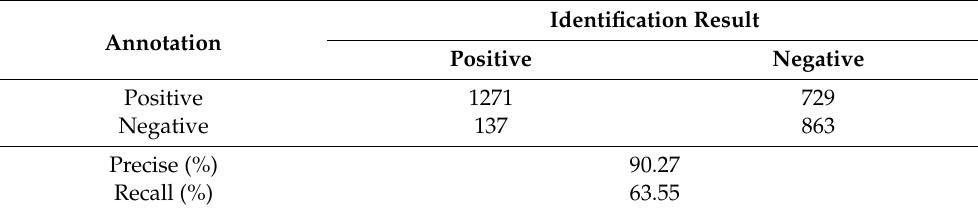
Table 1. The identification result of fold structures on F-dataset.